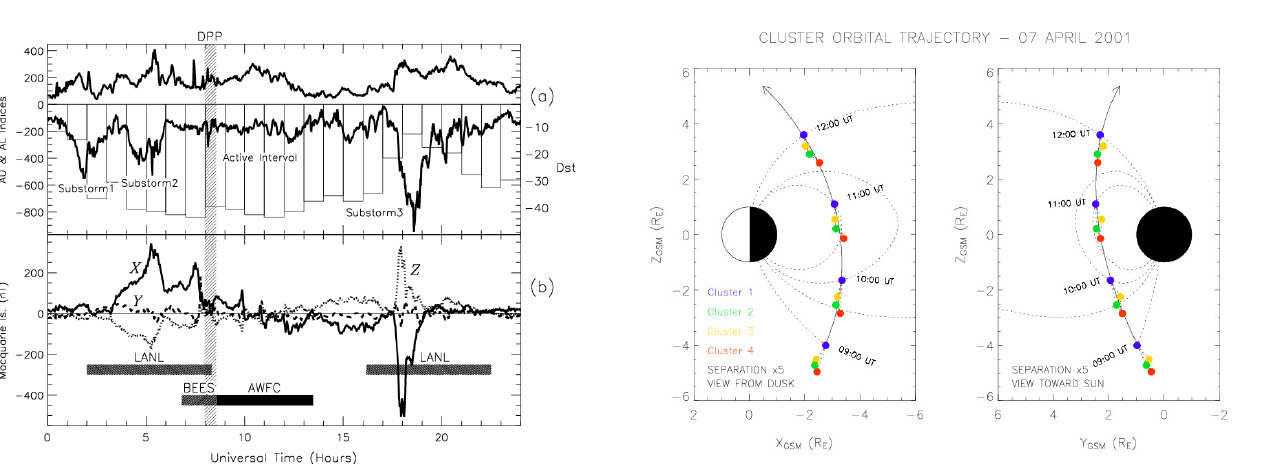
Fig. 1. (a) The AU and AL geomagnetic indices (bold curves) measured during 7 April 2001. These indices are a measure of eastward and westward current flow in the auroral ionosphere, respectively. The Dst index has been superimposed in the form of a faint bar chart. (b) Perturbations of the geomagnetic X (solid curve), Y (dashed curve), and Z (dotted curve) components measured by the magnetometer located on Macquarie Island (see Fig. 8). Two horizontal bars indicate approximate time intervals when the LANL satellites observed rapid decreases and increases in energetic particle flux at geosynchronous orbit. Horizontal bars also indicate when TIGER observed a band of equatorward expanding scatter (BEES), and an auroral westward flow channel (AWFC).